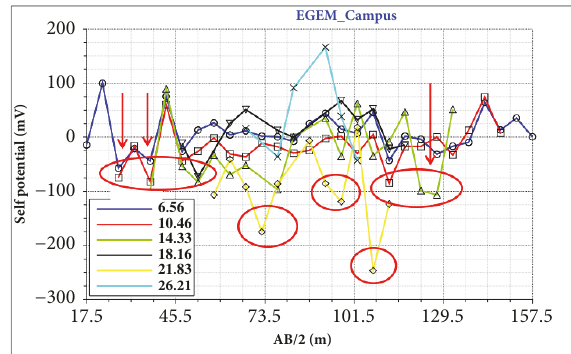
Figure13:PlotsofSPvaluesagainstHalfElectrodesSpacing (AB/2).